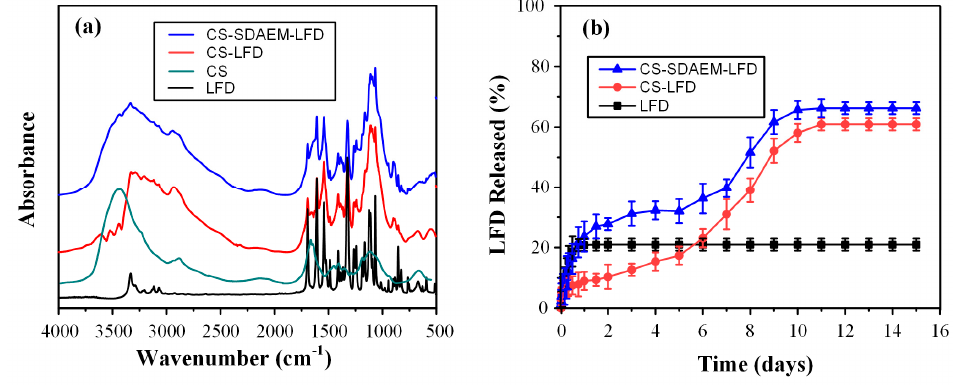
Figure 6. FT-IR spectra ( a ) and in vitro dissolution profile ( b ) of LFD loaded CS and CS-SDAEM